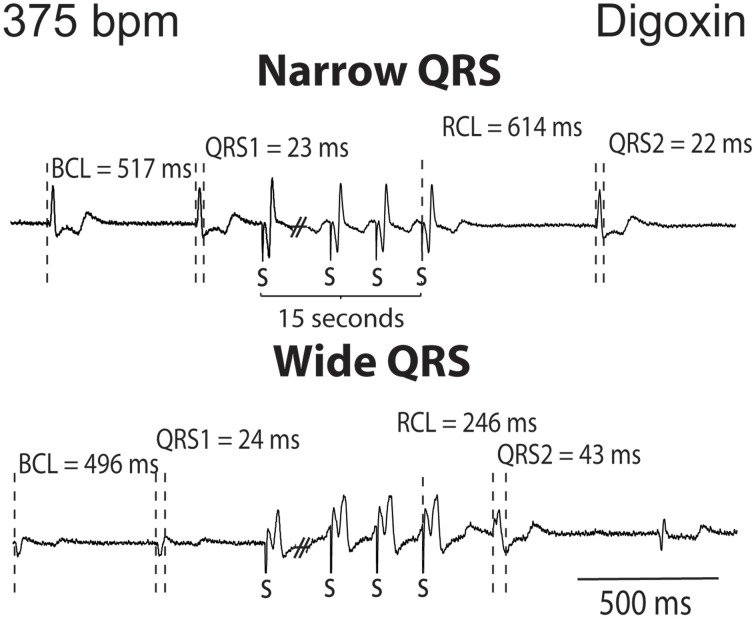
Digoxin recovery beats can manifest a late recovery-narrow QRS duration or an early recovery-wide QRS duration. Representative ECGs from digoxin experiments. Recovery beats with narrow and wide QRS complexes are shown in response to 15 s of rapid pacing. Figure illustrates representative cycle lengths (CL) and QRS of pre-paced beats, and the cycle length (RCL) and QRS or the recovery beat.